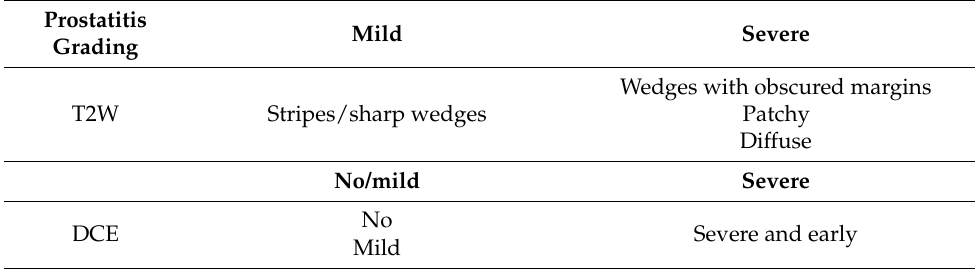
Table 1. On T2W, striped signal attenuations and sharp wedges were defined as mild, while blurry wedge-shaped, patchy, and diffuse alterations were combined and defined as severe. For dynamic contrast-enhanced (DCE) imaging, no or mild enhancement were combined. Prostatitis Mild Severe Grading Wedges with obscured margins T2W Stripes/sharp wedges Patchy Diffuse No/mild Severe No DCE Severe and Mild